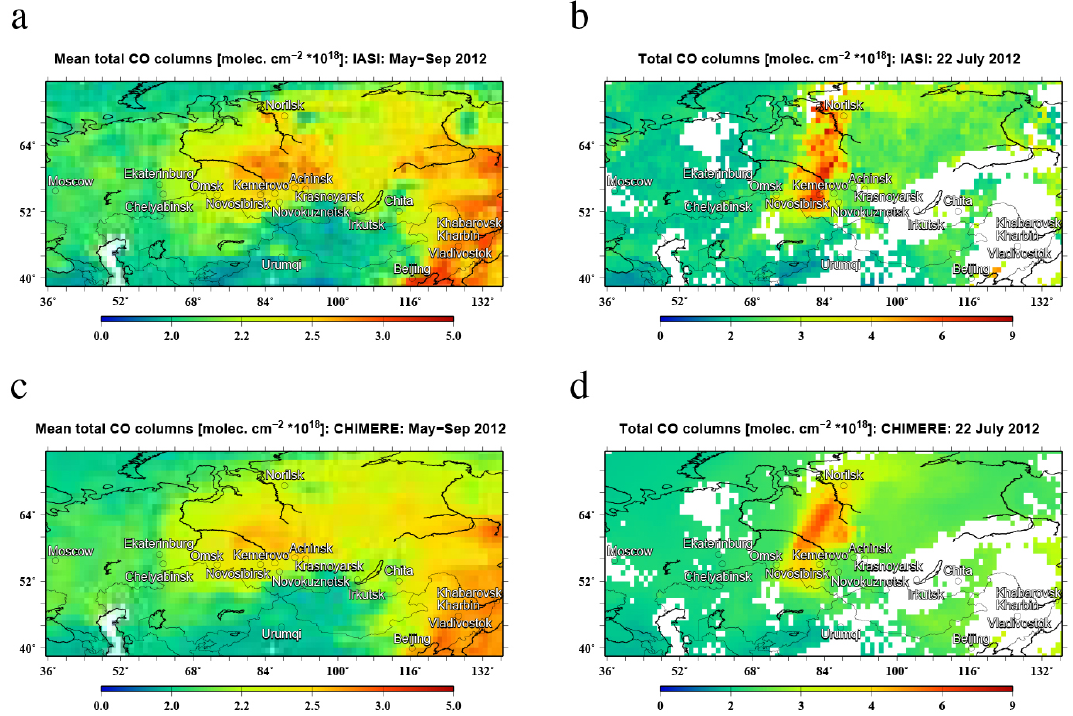
Figure 5. Spatial distributions of the total CO columns according to (a, b) IASI measurements and (c, d) simulations after removing the bias not associated with fire emissions: (a, c) mean values over the modeled period (May–September 2012), (b, d) daily values for a selected day (22 July 2012). The measurements and simulations shown were withheld from the emission estimation procedure (see Sect. 4 for details).